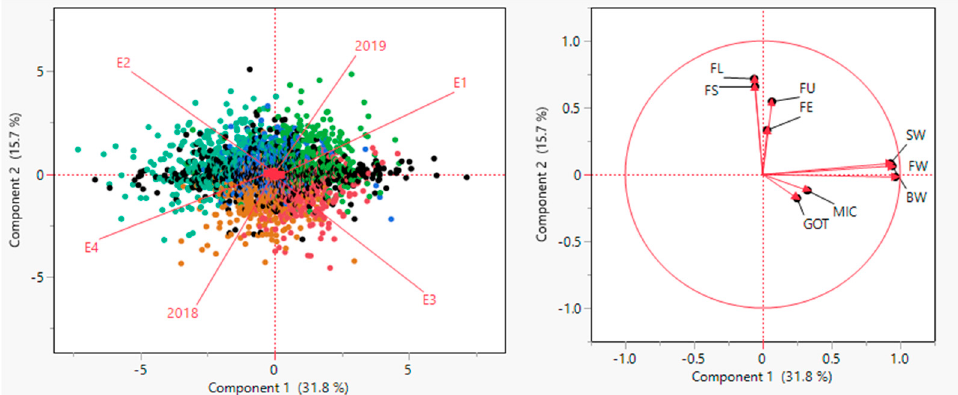
Figure 4. Summary plots with ( left ) biplot between PC1 and PC2 displaying the distribution of 355 upland accessions across treatment effects and years; ( right ) contribution of different traits in variation for genotypes, treatment effects, and years.